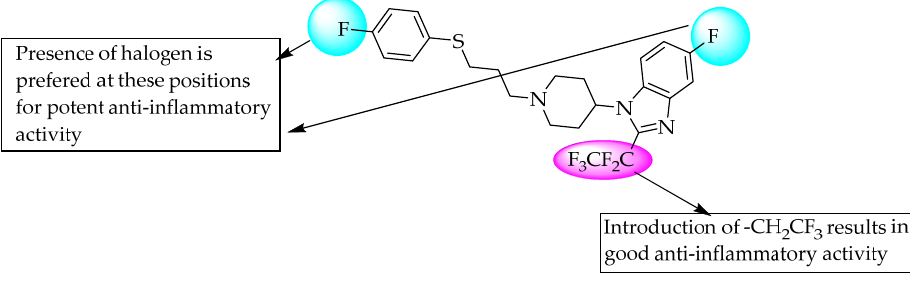
Figure 14. SARs of 1,2,5-trisubstituted benzimidazole as CCR3 receptor inhibitor.